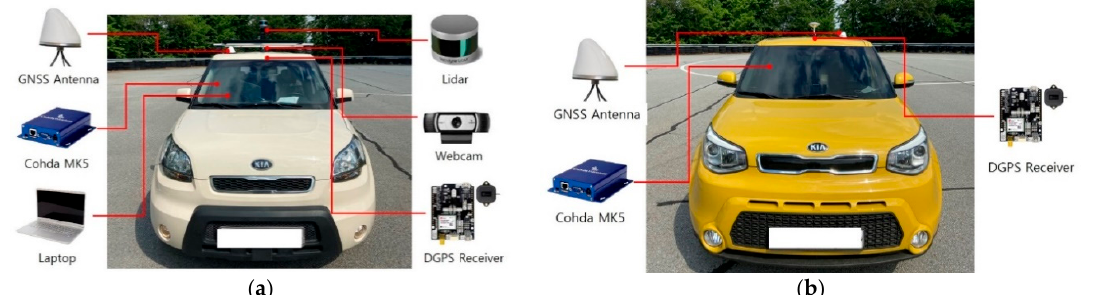
Figure 11. ( a ) EV’s sensor configuration; ( b ) SV’s sensor configuration.